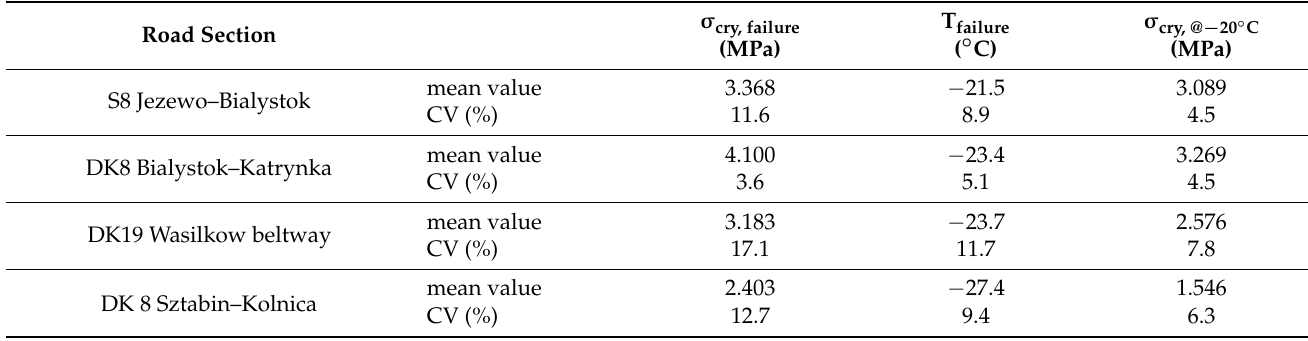
Table 4. Test results of TSRST for the binder course.